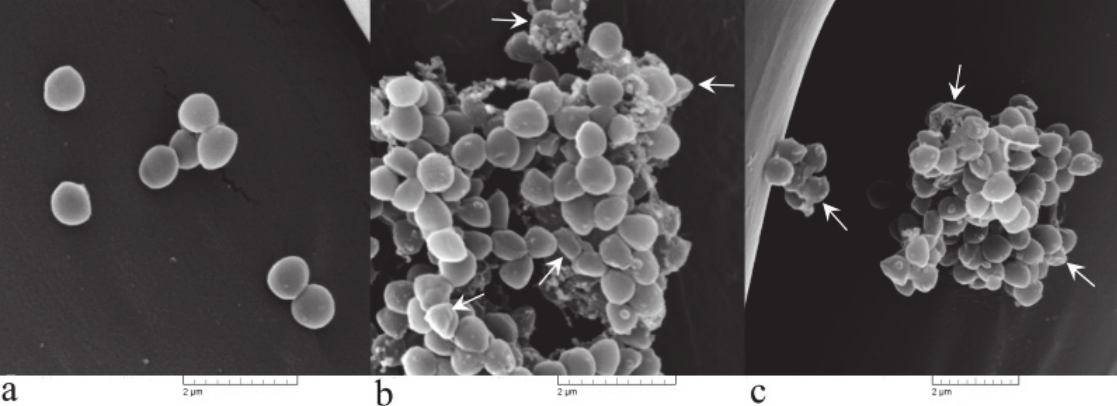
Figure 5. SEM photomicrographs showing the effects of PlLm extract on S. aureus cell morphology: ( a ) control; ( b , c ) cells exposed for 4 h to MIC and 2 × MIC, respectively. White arrows indicate irreversible morphological damage of treated bacterial cells and cellular debris.